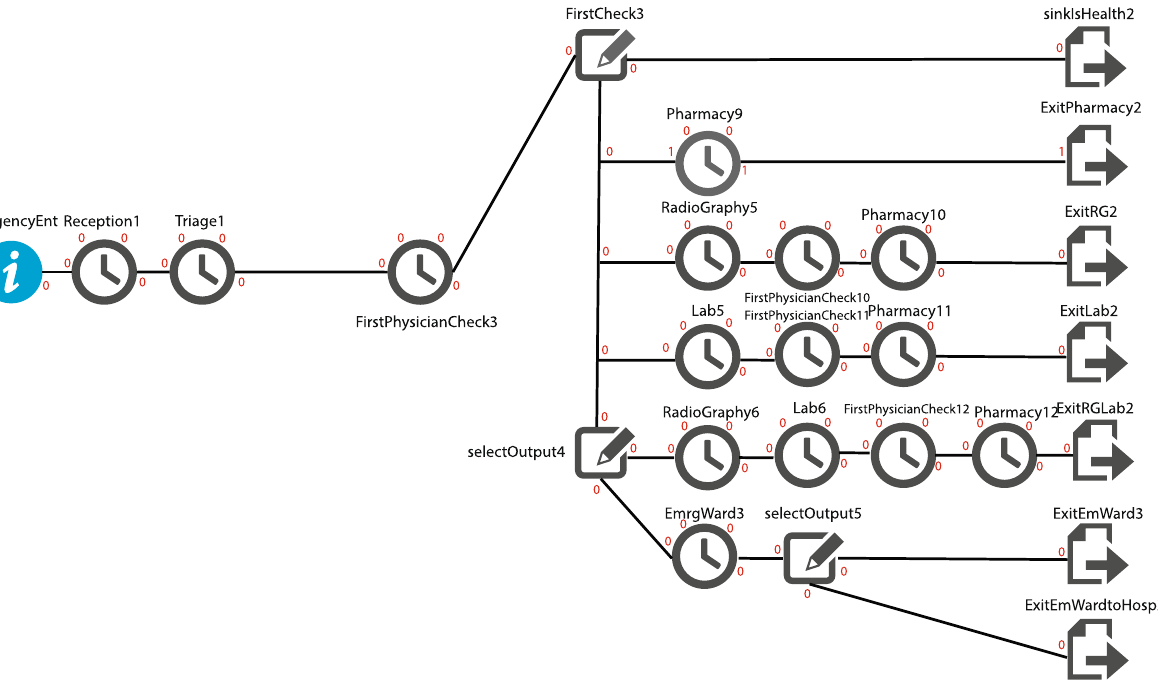
Figure 3. A simulation model for emergency patients with high priority fairness